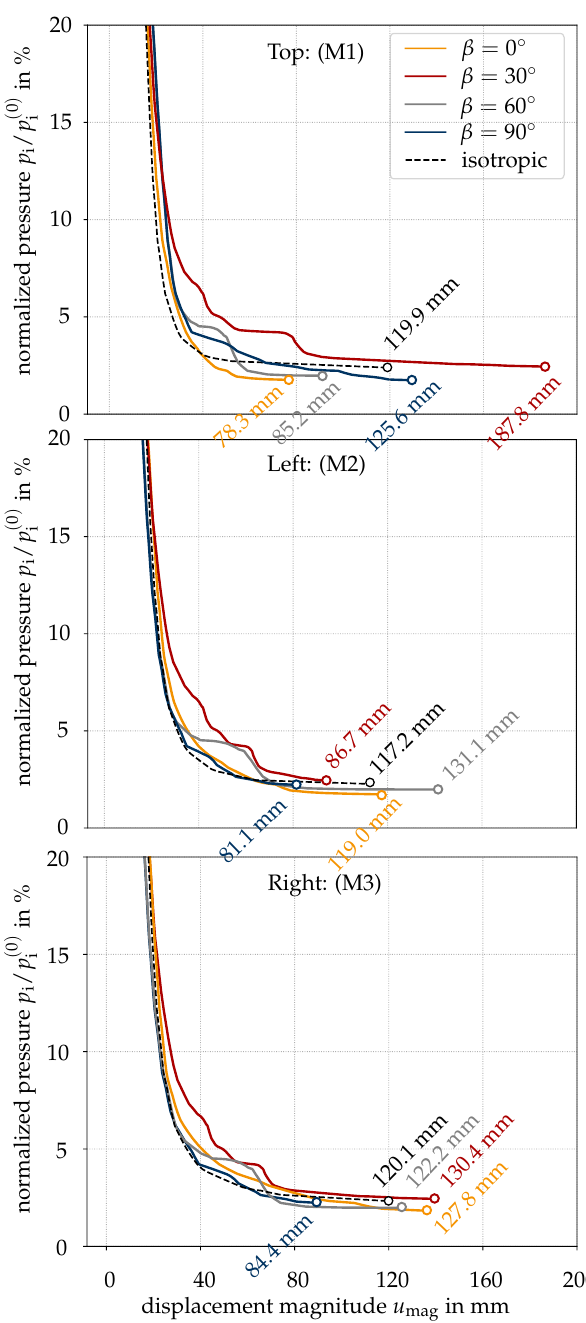
Figure 12. Normalized surface pressure p i / p 0 i as a function of the displacement magnitude u mag Figure 13. Normalized surface pressure p i / p ( 0 ) as a function of the displacement magnitude u mag i for three characteristic points, i.e., Top: M1 (top), Left: M2 (middle) and Right: M3 (bottom) and for three characteristic points, i.e., Top: M1 ( top ), Left: M2 ( middle ) and Right: M3 ( bottom ) and the four inclination angles of the stratification planes β = 0 ◦ (orange), 30 ◦ (red), 60 ◦ (grey) and 90 ◦ the four inclination angles of the foliation planes β = 0 ◦ (orange), 30 ◦ (red), 60 ◦ (grey) and 90 ◦ (blue) (blue) compared to the isotropic (dashed) simulation. compared to the isotropic (dashed)